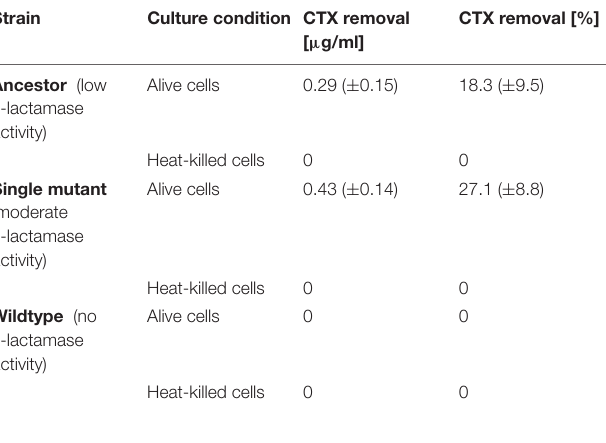
TABLE 2 | Cefotaxime removal from liquid medium in the bioassay (from the initial 1.58 µ g/ml) by strains expressing different β -lactamase alleles or no β -lactamase, after 3 h of